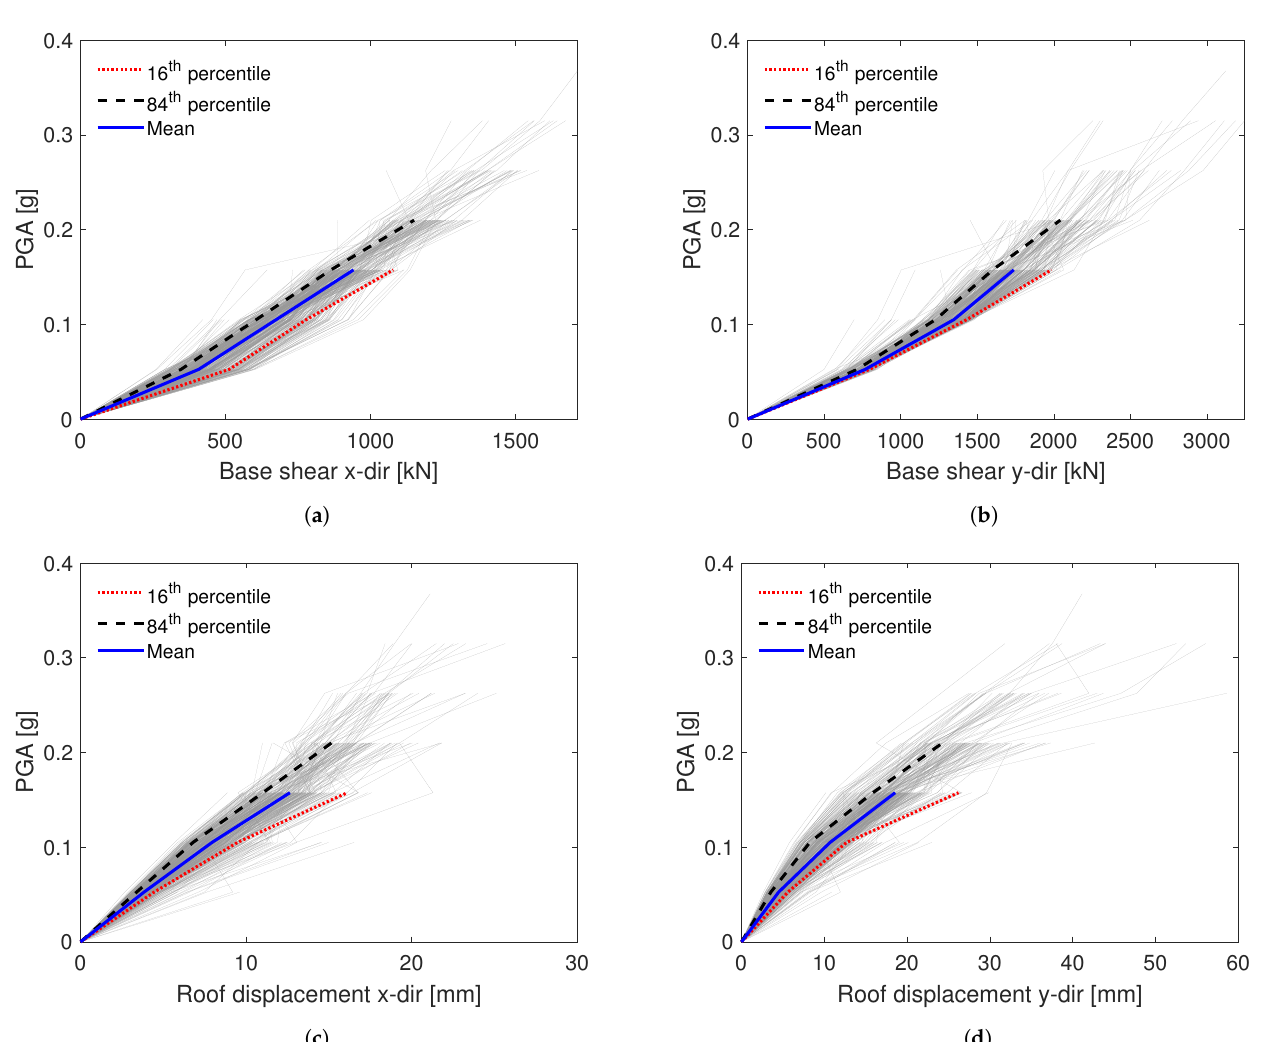
Figure 16. Lausanne Malley model IDA curves for maximum values of seismic demand parameters: ( a ) Total base shear in x-direction. ( b ) Total base shear in y-direction. ( c ) Average roof displacement in x-direction. ( d ) Average roof displacement in